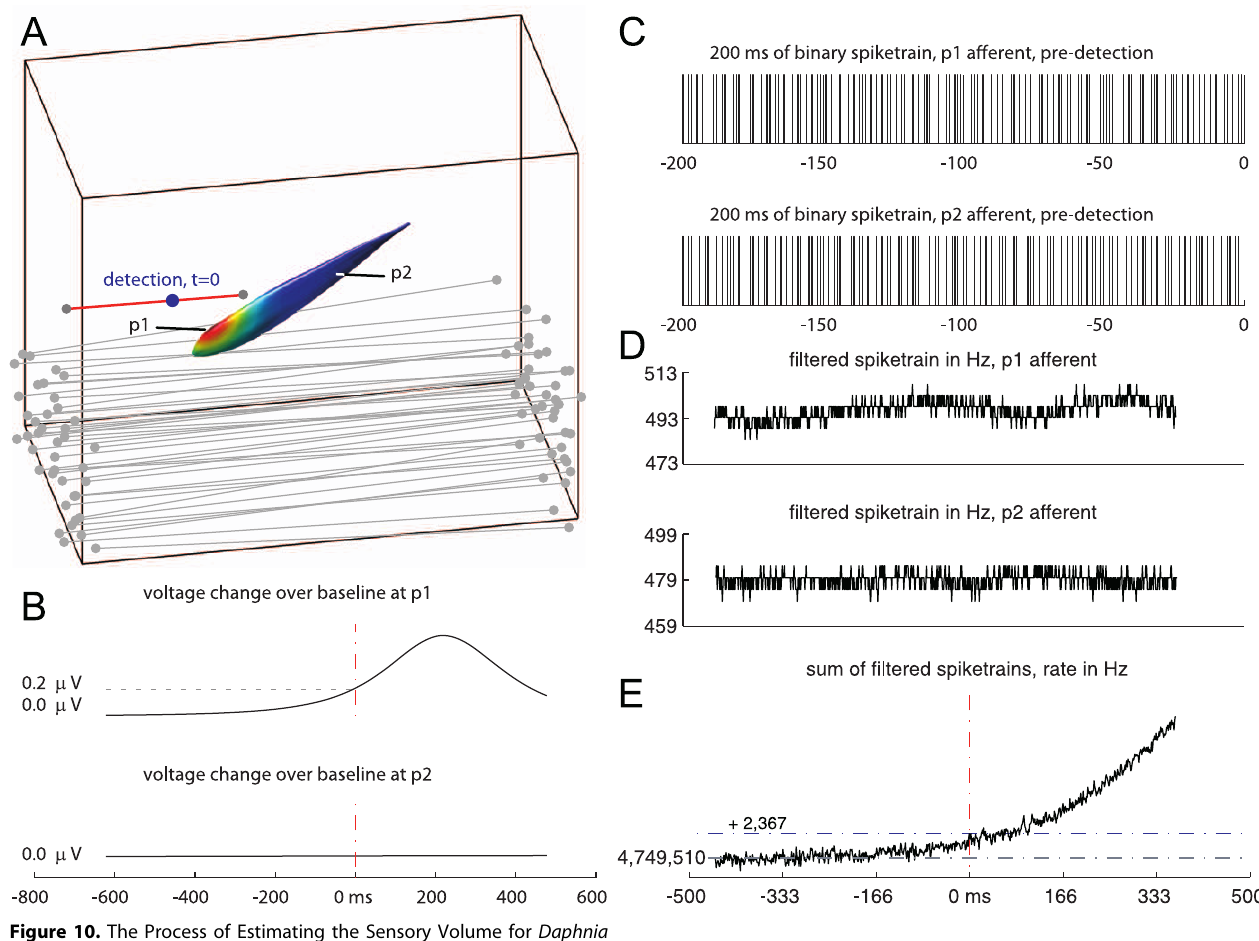
Figure 10. The Process of Estimating the Sensory Volume for Daphnia (A) First, simulated prey are moved along forward and backward rays at a speed of 100 mm/s. A subset of the 1,014 forward rays is shown in gray. The red ray indicates a trajectory where prey detection occurred (blue dot, t ¼ 0). (B) The estimated change in voltage across the skin at p1 , induced by the relative motion between the fish and prey, is shown in comparison with the voltage across the skin at p2 , further away from the stimulus. Detection occurred in this case with a 0.2- l V change on a 1-mV baseline, a 0.02% change. (C) A short 200-ms segment of the spike trains corresponding to afferents at p1 and p2 . (D) The spike trains are low-pass filtered to obtain a continuous estimate of spiking rate changes relative to baseline. (E) On each 1-ms time step, the filtered activity of all afferents is summed. The summed activity is thresholded at a level that gives a 10% false alarm rate over ten repeats (one false detection); the location of the prey at the time of threshold crossing is used to define the detection point. Steps A–E are repeated for each of 1,014 forward rays and of the same number of backward rays to construct a cloud of detection points. These points are then processed to form the SV